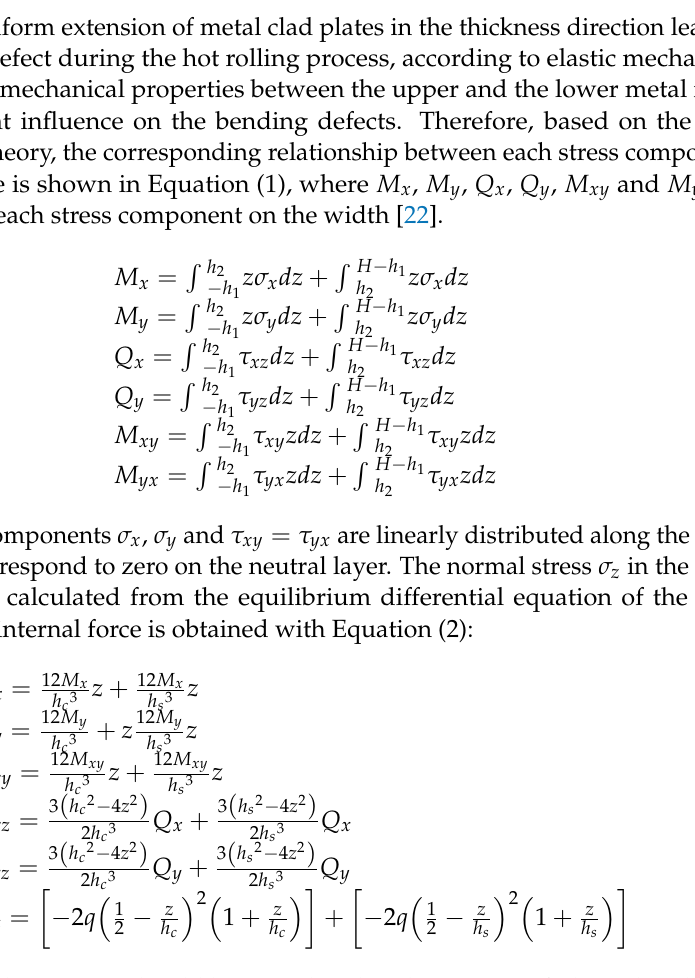
Figure 1. Structural model of the metal clad plate. The non-uniform extension of metal clad plates in the thickness direction leads to the shape bending defect during the hot rolling process, according to elastic mechanics. The difference of the mechanical properties between the upper and the lower metal materials has an important influence on the bending defects. Therefore, based on the medium thick- ness plate theory, the corresponding relationship between each stress component and the internal force is shown in Equation (1), where M , and M are the x yx internal force of each stress component on the width [22].